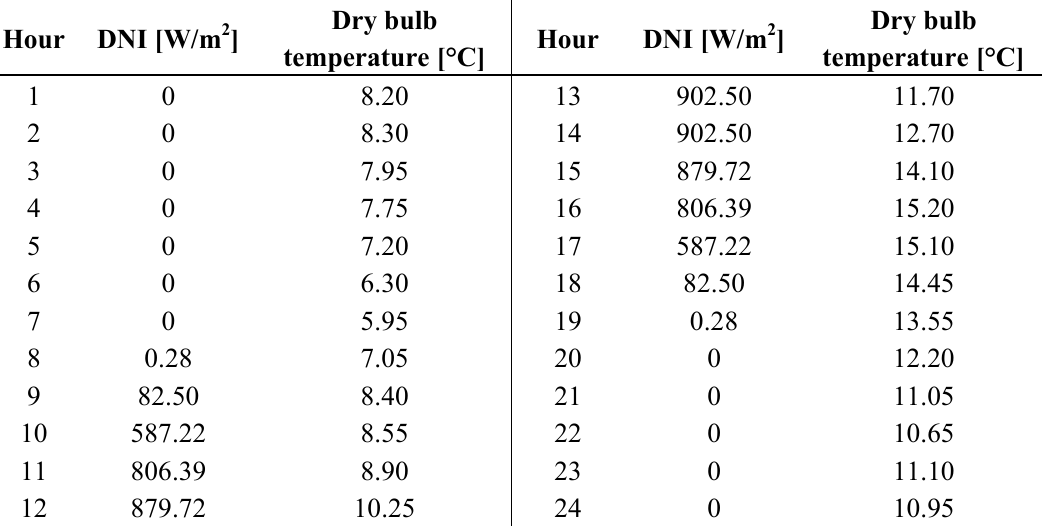
Table 3. Direct normal insulation and temperature data for the selected winter day